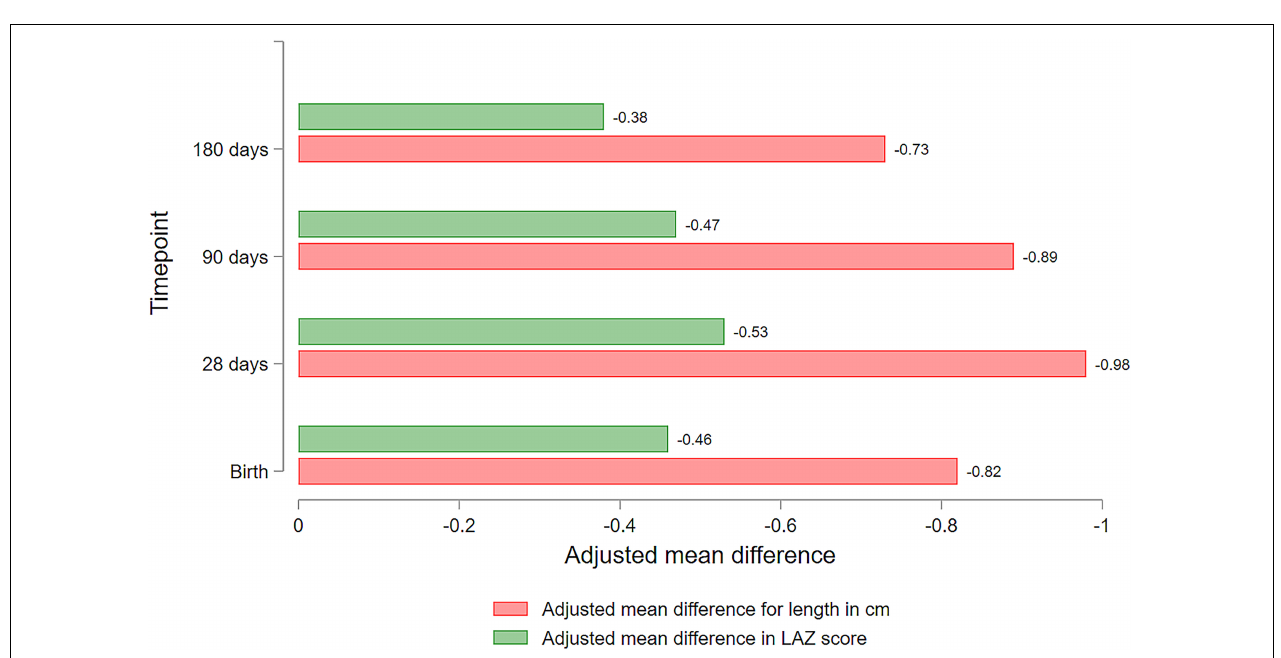
FIGURE 4 | Mean difference (MD) in attained length and length for age z -scores (LAZ) between appropriate-for-gestational-age LBW (AGA-LBW) and SGA-LBW infants.